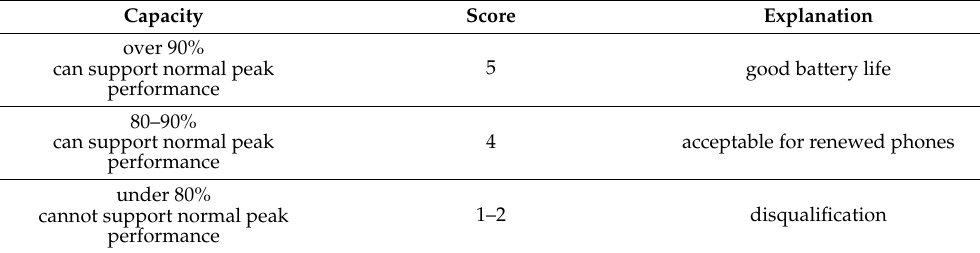
Table A1. Explanation of the battery’s maximum capacity.